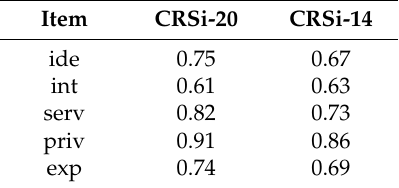
Table 9. R 2 of the first level latent variables of the interreligious CRS in the confirmatory factor analysis. Item CRSi-20 CRSi-14 ide